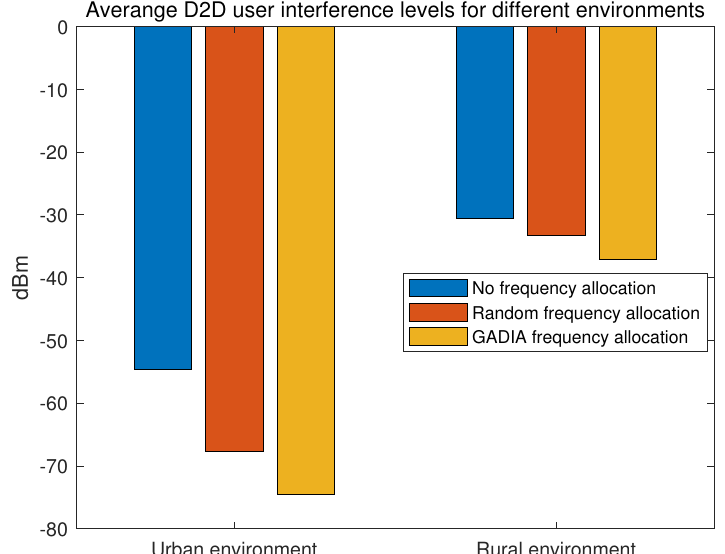
Figure 17. Mean D2D user interference level for different environments after 200